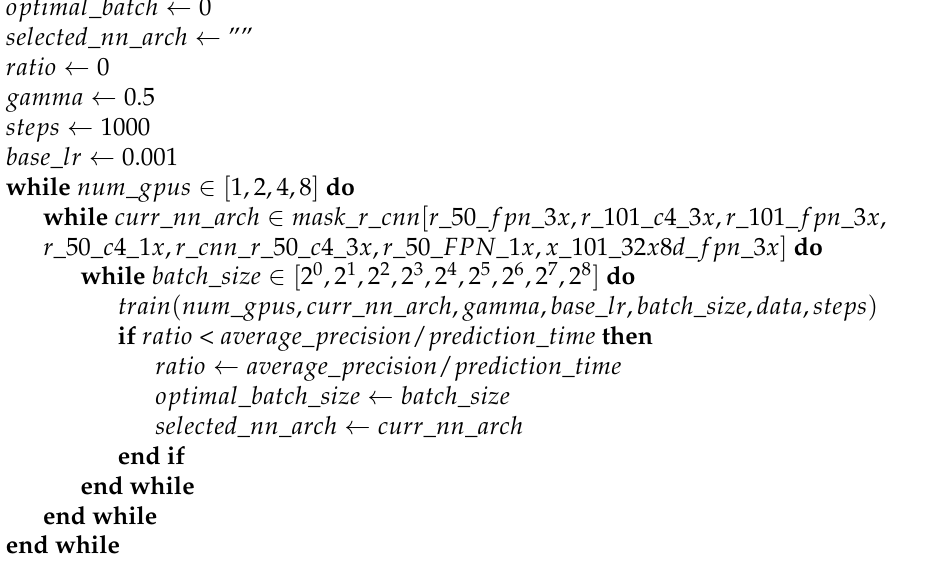
Algorithm 2 Instance segmentation: implementation steps needed to select the network architecture and create the prediction